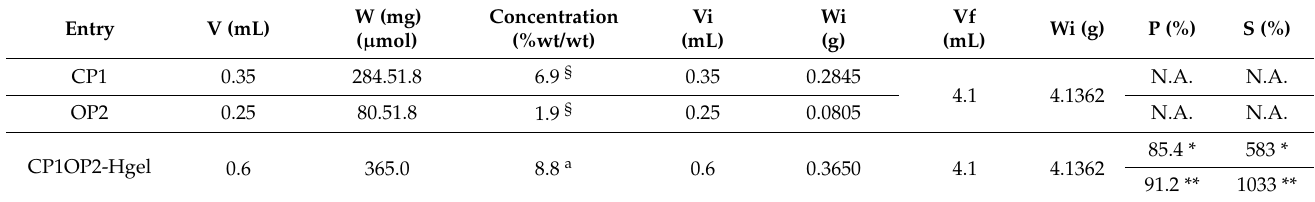
Table 3. Experimental data for CP1OP2-Hgel preparation, details about CP1 and OP2 concentrations in the prepared hydrogel, porosity, and maximum swelling capability (by volume and by